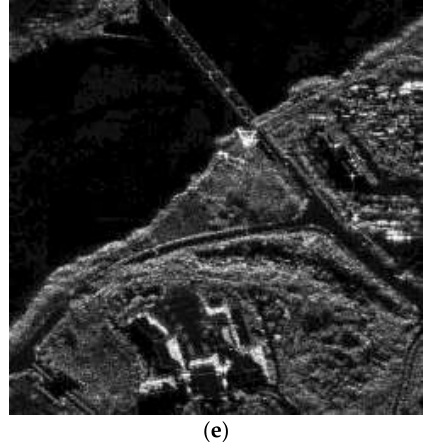
Figure 8. A typical area in Figure 6 are zoomed and compared with the other methods. ( a ) Focused without MOCO; ( b ) Focused with only range-varying PGA; ( c ) Focused combining stripmap RDM and range-varying PGA; ( d ) Focused combining sliding spotlight RDM without WTLS and range-varying PGA; ( e ) Focused combining sliding spotlight RDM with WTLS and range-varying PGA.